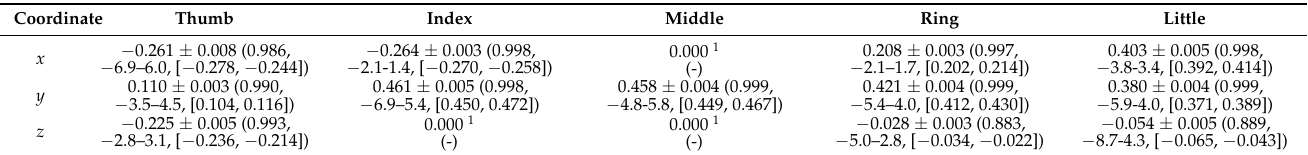
these models were below 1.7 mm. Table 3. Coefficients for estimating the carpometacarpal (CMC) joint center of the thumb and the metacarpophalangeal (MCP) joint centers of the four fingers (B, where x = B × hand breadth; C, where y = C × hand length; D, where z = D × hand breadth for the thumb and z = D × hand length for the ring and little fingers) based on 15 male hands (mean ± standard error, R 2 , maximum residual range, and 95% confidence interval).